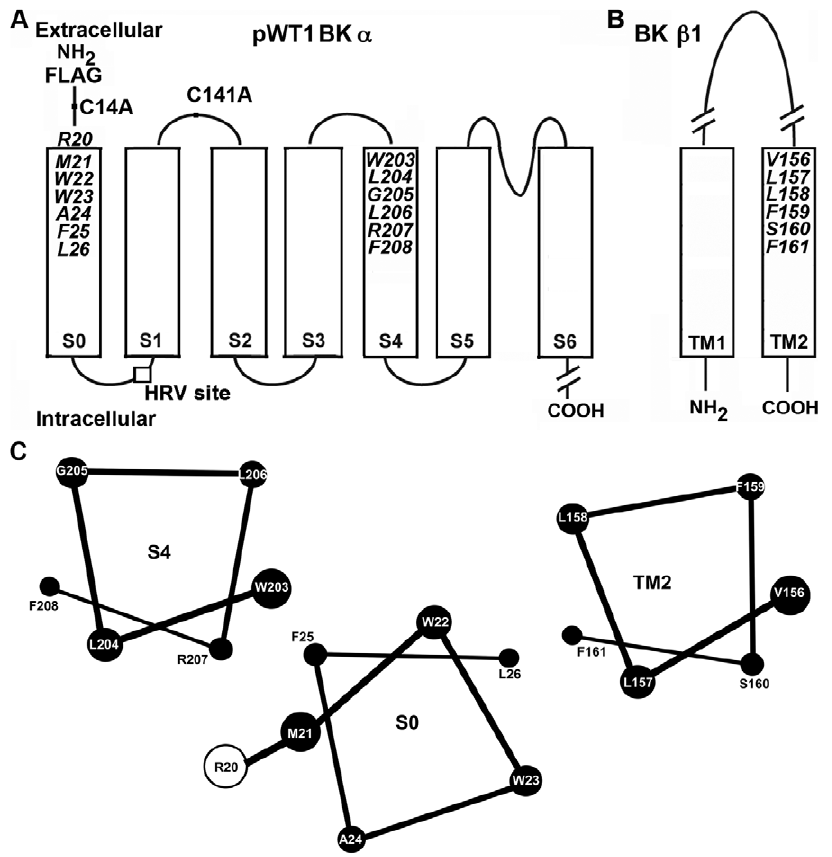
Figure 1. Membrane topology of BK a and b 1 subunits. (A) Mouse BK a residues mutated to Cys in the first two turns of S0 and S4. An HRV-3C protease cleavage site was inserted in the S0-S1 loop (box), the two native extracellular Cys, C14 and C141, were mutated to Ala, and a FLAG-epitope (MDYKDDDDKSPGDS) was added to its N-terminus. This construct is termed pWT1 a . (B) Mouse BK b 1 residues mutated to Cys in the first two turns of TM2. (C) The residues at the extracellular ends of S0, S4, and TM2 in the membrane are represented as ideal a helices, as viewed from the extracellular side. The relative positions and orientations of the helices optimize the average observed endogenous crosslinking between Cys.